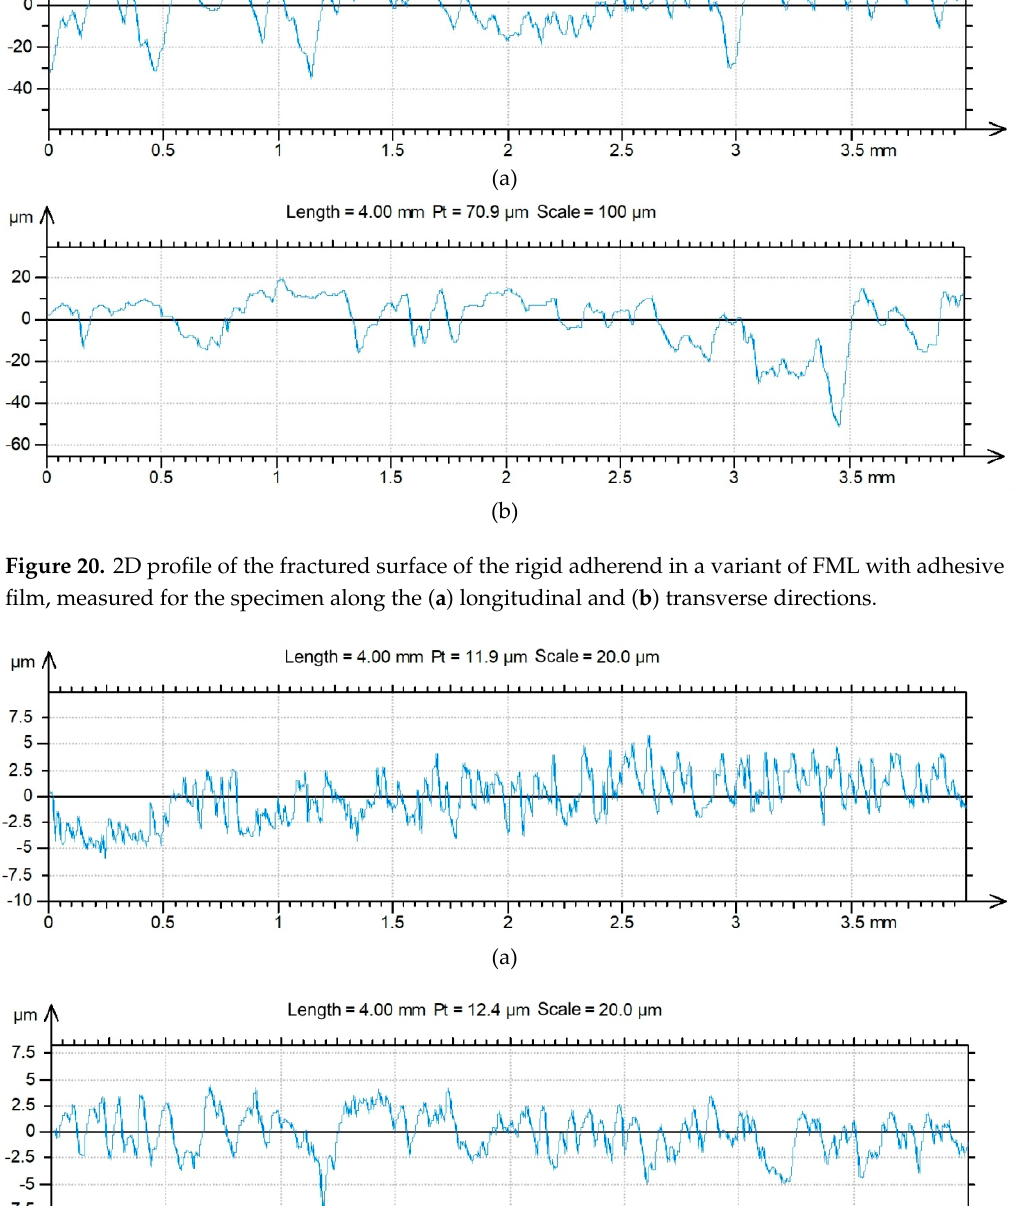
Figure 21. 2D profile of the fractured surface of the rigid adherend in a variant of FML without adhesive